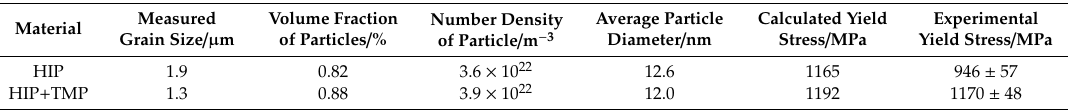
Table 2. Calculated yield stress values and experimental yield stress values of Al and Zr added 15Cr-ODS alloy before and after